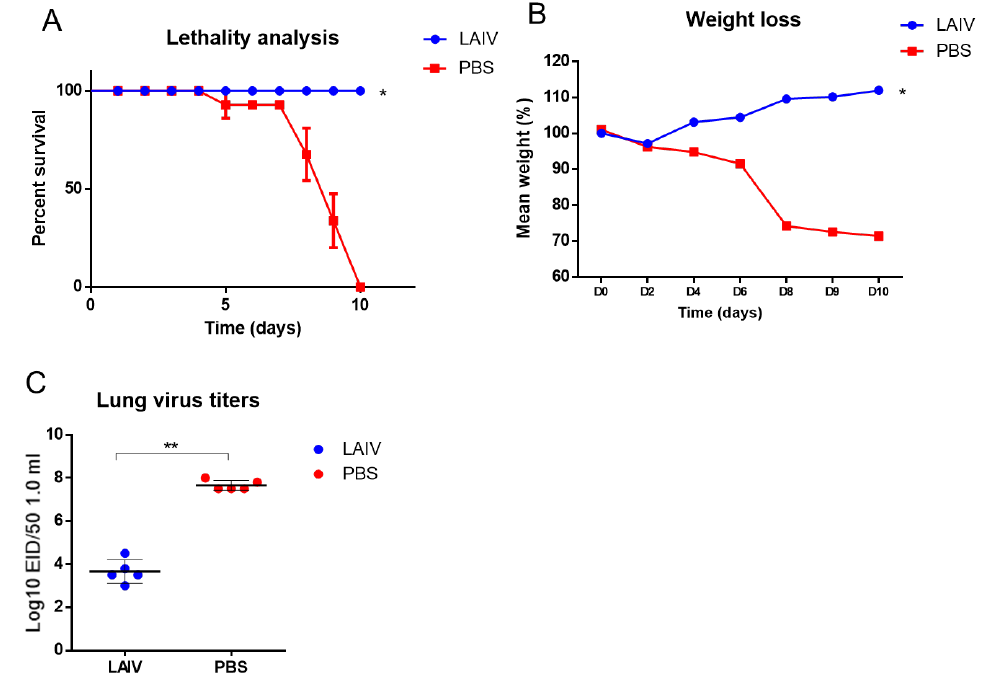
Figure 2. Challenge using 10 MLD50 of A/South Africa/3626/13(H1N1)pdm09 influenza virus on the 6th day, following A/17/South Africa/2013/01 immunization. * p < 0.05, ** p < 0.01 compared to PBS group. ( A ) Survival proportions ( n = 10 per group). ( B ) Weight loss ( n = 10). ( C ) Infectious-virus isolation from the lungs, 48 h after virus challenge ( n = 5).